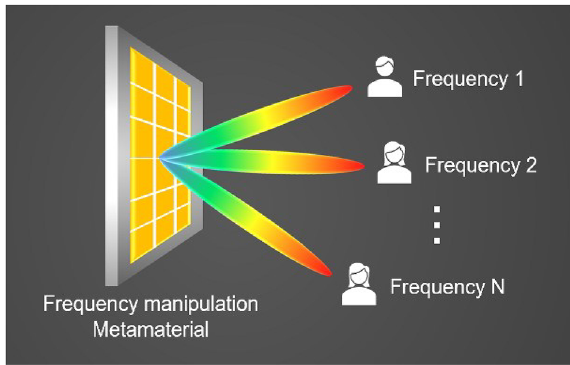
Figure 18: Frequency manipulation metamaterial.